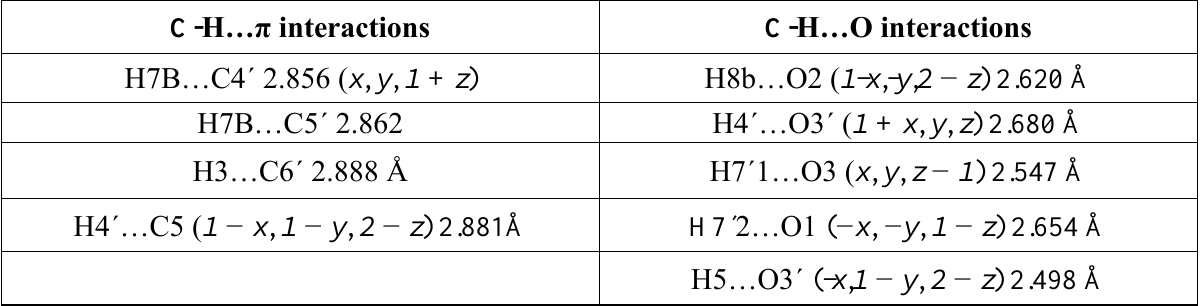
Table 2. Intermolecular interactions in compound 2